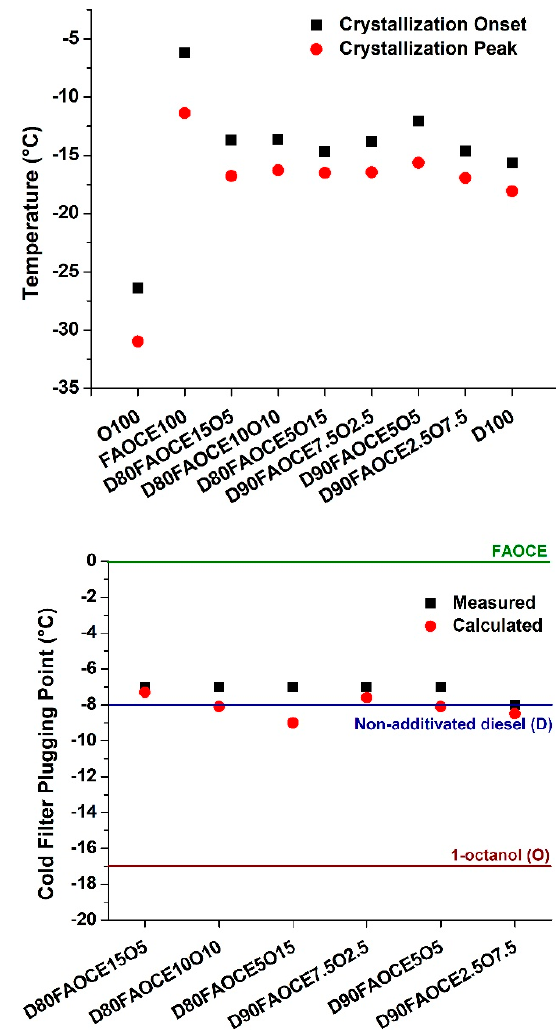
( b ) Figure 7. Comparison of measured and calculated density values of binary ( a ) and ternary ( b ) blends of 80, 85, 90, 92.5, 95, and 97.5 vol% diesel. The addition of FAOCE in these binary and ternary blends with mineral diesel and/or 1-octanol resulted in an increase in the blend’s density above the pure mineral diesel den- sity value. Again, due to the attractive intermolecular forces between the long chains of FAOCE, diesel, and 1-octanol, as well as good 1-octanol miscibility with other components [24], overall blend density increases with their volume fractions. The welcomed density similarities between 1-octanol and mineral diesel were also reported by Ashok et al. [34]